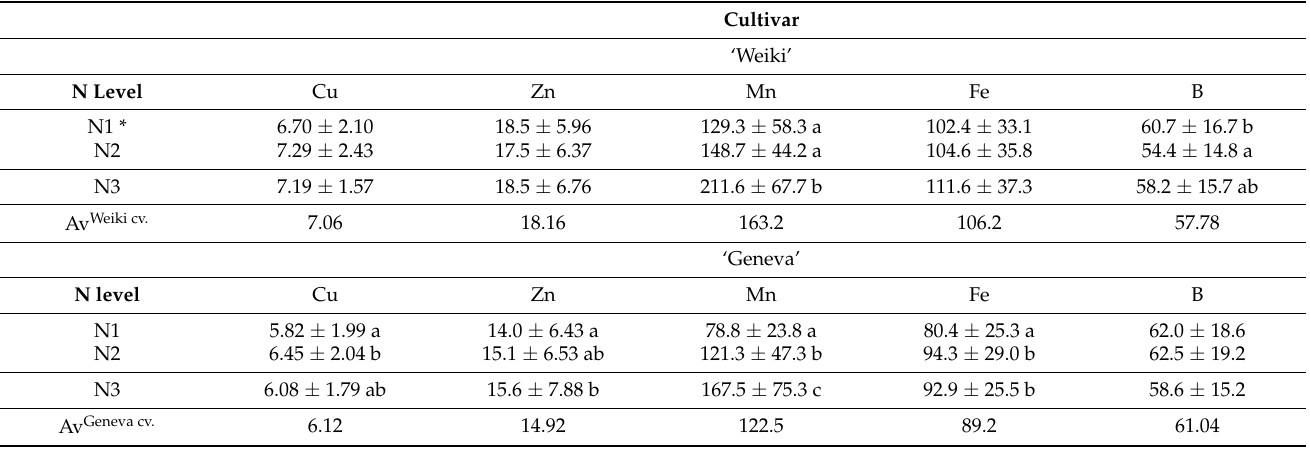
Table 3. Leaf micronutrient concentration (mg kg − 1 DW): cultivar and N effects. Cultivar